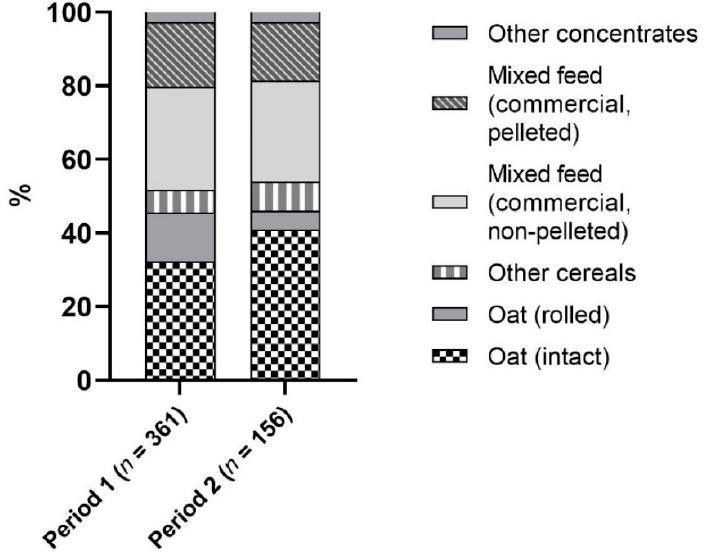
Figure 1. Proportional frequency of feedstuffs examined. Other concentrates ( n = 27): dried pulp ( n = 8), carrots ( n = 5), bran ( n = 4), milled supplementary feed ( n = 3), linseed ( n = 3), maize ( n = 3), milled linseed ( n = 1).